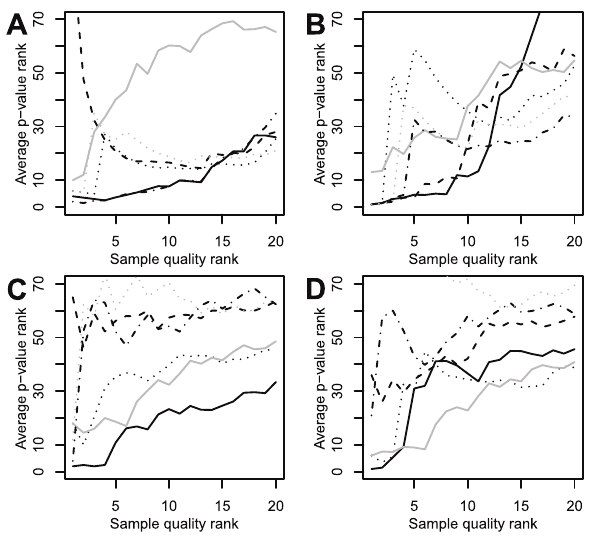
Figure 5. Comparison of quality metrics with Bayes classifier posterior probabilities. Samples were classified by a naive Bayes classifier. Bad quality samples should not fit the classification well, and have lower probabilities. The average of the ranks of the posterior probabilities of the N lowest quality samples is shown. Quality of the samples was determined with SNAGEE (solid line), MDQC (dashed line), GNUSE (dotted line), NUSE (grey dotted line) and RLE (dash-dot line). Classification was done on breast cancers according to ER status ( A :GSE20194 and B :GSE4922); on muscle disease samples according to gender ( C ) or to the muscle disease type ( D ), one class vs. the rest. The solid grey line uses the samples assigned the highest SNR (and so likely to be biological outliers) by SNAGEE. breast was indeed lower than expected. Another issue with this study is that a melanoma cell line has been annotated as a renal cell line (Figure S2), leading to a lower %DEG for the renal tissue. For GSE2003 (NCI platform), two leukemia samples were given a